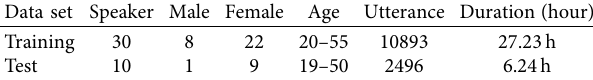
Table 1: Statistics of THCHS-30 database.